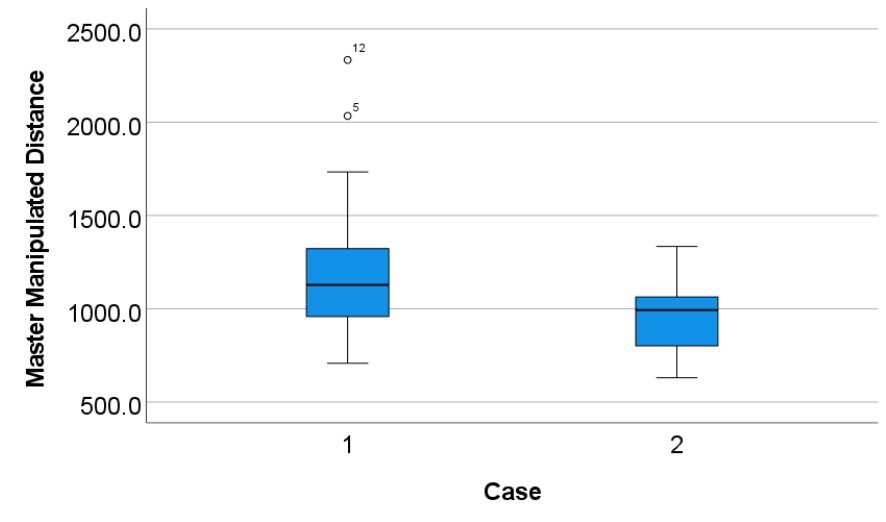
Figure 7. Manipulated distance of the master device (Case 1: Position control and Case 2: Hybrid control).